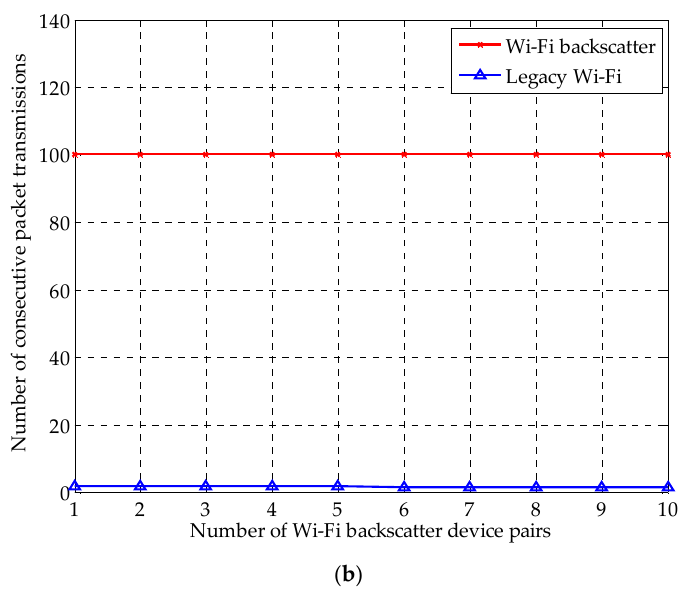
Figure 10. Variation of throughput and the number of consecutive packet transmissions for multiple pairs of Wi-Fi backscatter devices: ( a ) throughput; and ( b ) number of consecutive packet transmissions.